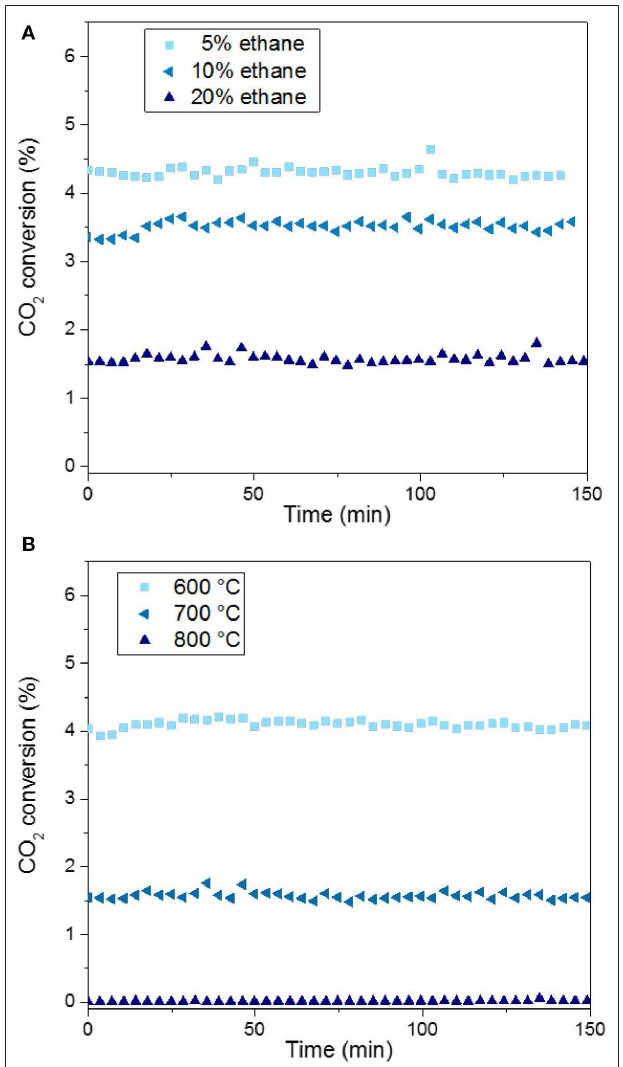
FIGURE 6 | CO 2 conversion over MoC/TiO 2 -P as a function of the amount of ethane used for carburization at 700 ◦ C (A) and the carburization temperature used for 20% ethane (B) . Catalytic conditions: 400mg of catalyst, 50ml min − 1 , 250 ◦ C, 30 bar, H 2 :CO 2 = 3:1, 150min on stream after stabilization of the temperature.